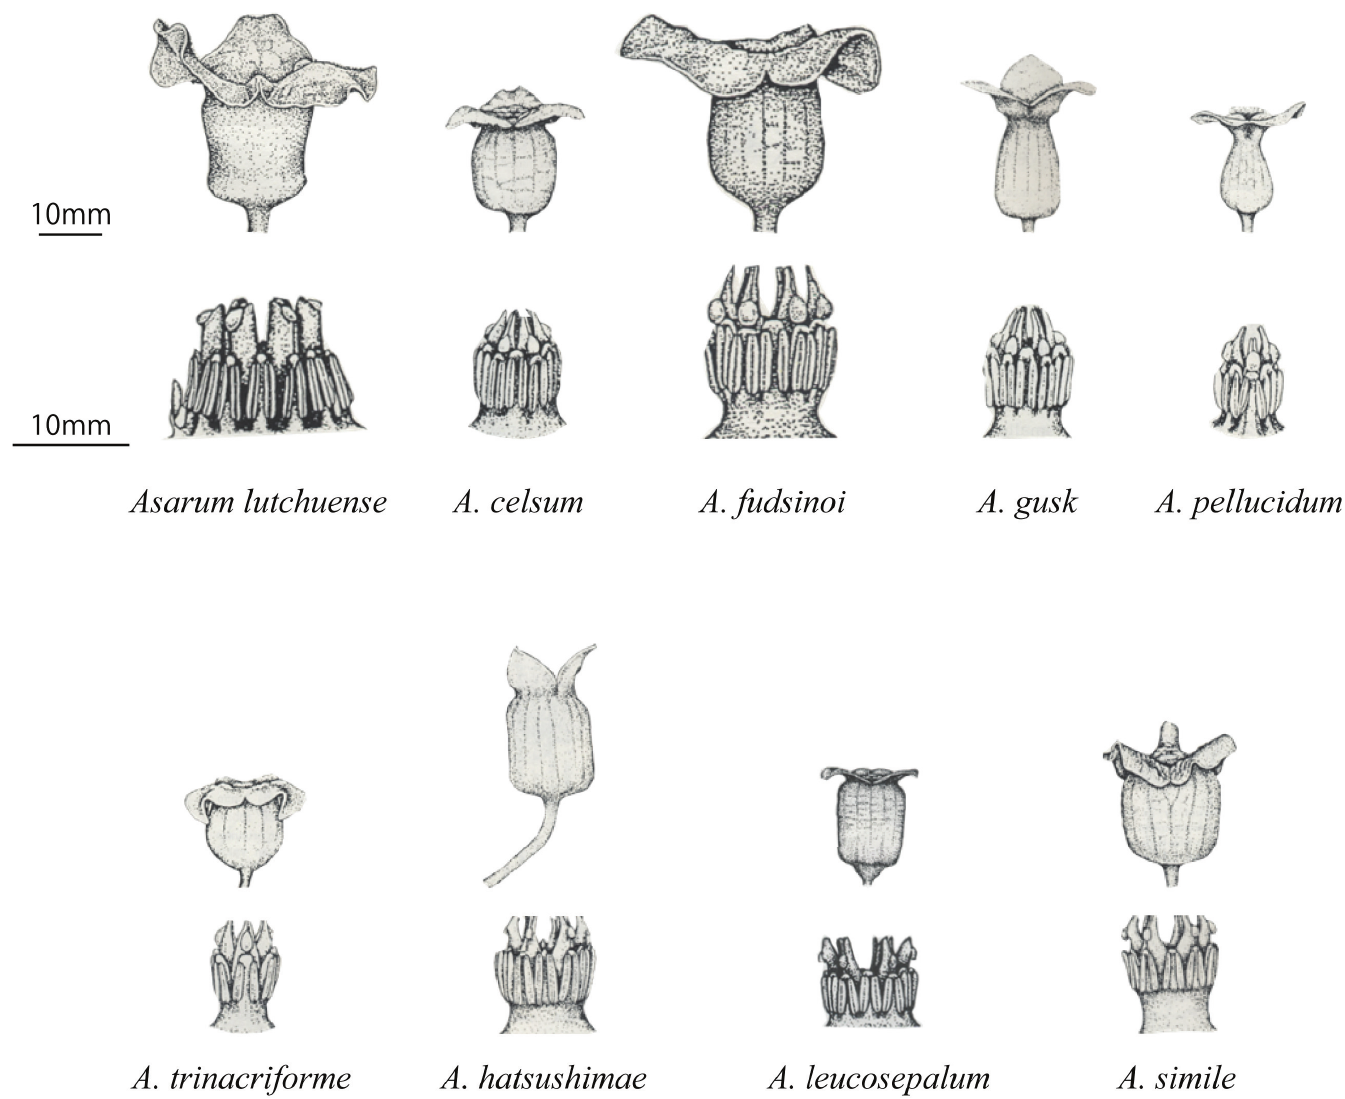
Fig 2. Line drawings of the nine Asarum species showing their flowers and reproductive organs.